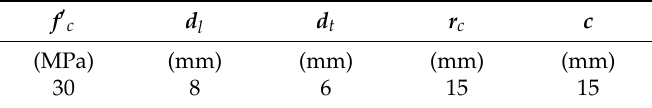
Table 5. Common properties for set 1 specimens.